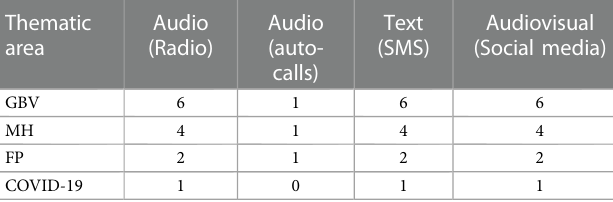
TABLE 1 Number of developed messages by thematic area. Thematic